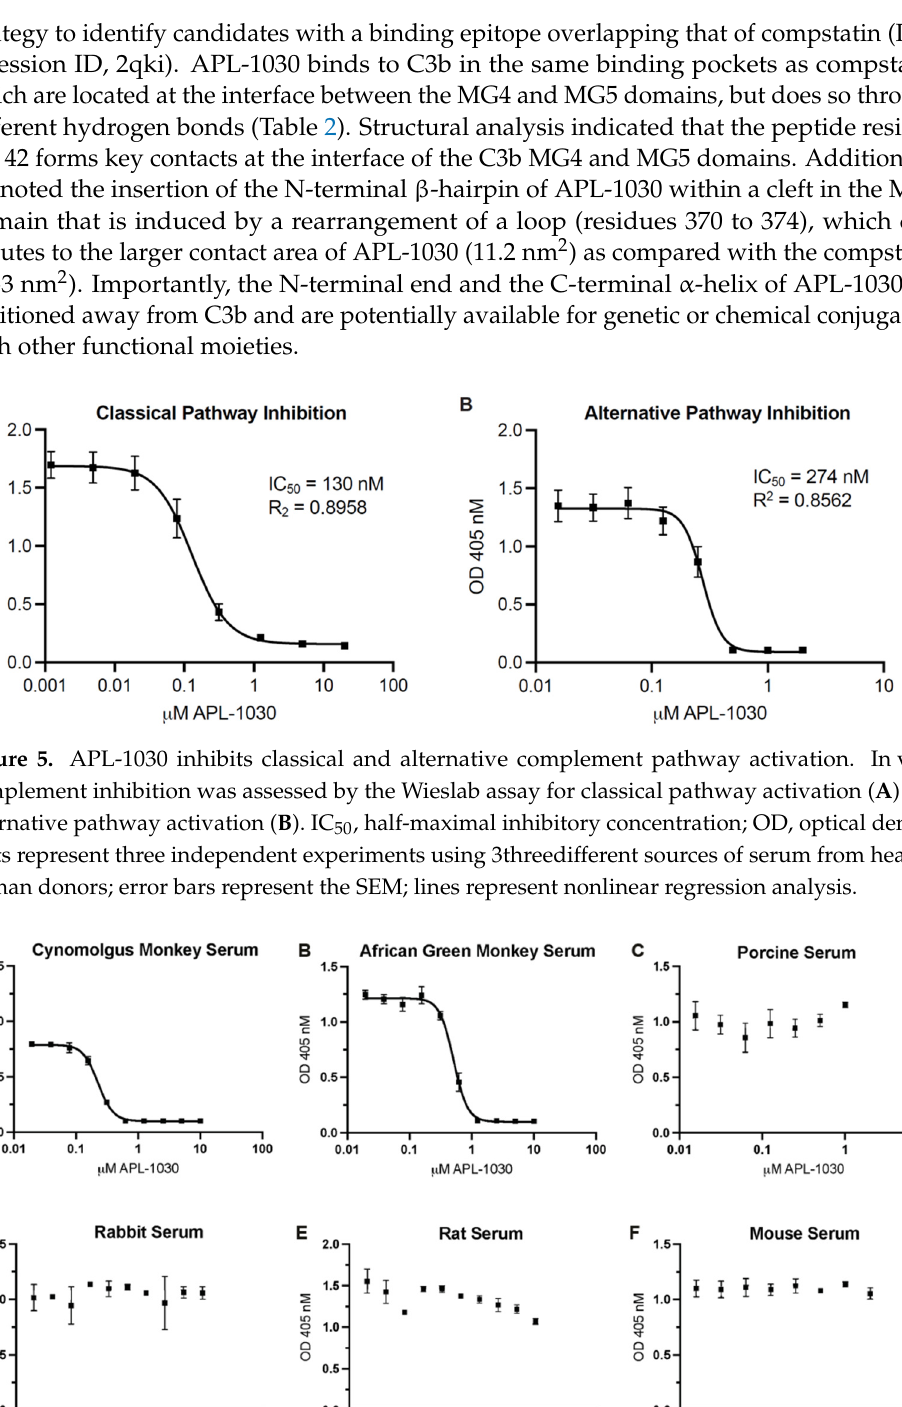
Nanofitin. Figure 7. APL-1030 is stable for 1 month at 40 °C. Thermal stability of APL-1030 was assessed by differential scanning calorimetry at time 0, 2, and 4 weeks of constant exposure to 40 °C temperature. Cp, specific heat capacity; DS, differential scanning. N = 1 sample per test condition. 3.1.5. Structure of the C3b–APL-1030 Complex To determine the binding site of APL-1030 on its target, a crystal structure of C3b- bound APL-1030 was obtained at a spectral resolution of 0.3 nm. The C3b-binding site of